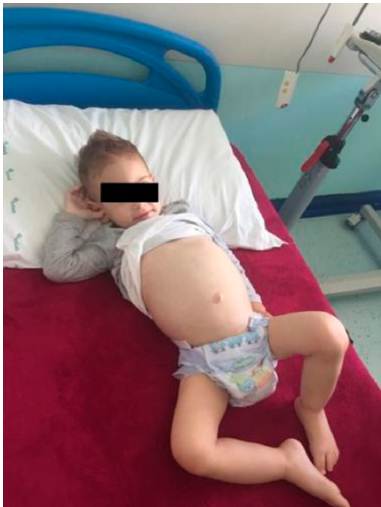
Figure 1. A 23-month-old child at admission six months after the onset of Guillain-Barré syndrome (GBS) appeared pale and mildly dehydrated, with scarce adiposity and muscle hypotrophy. He was unable to walk and had normal mental status, low muscle tone, absence of deep tendon reflexes in both legs, normal strength and sensorial evaluation of the upper limbs, and no deficit of the cranial nerves, nor cerebellar or meningeal signs. The Babinski sign was bilaterally absent, and the child had cold, swollen ankles and an abdomen severely distended with active peristalsis.